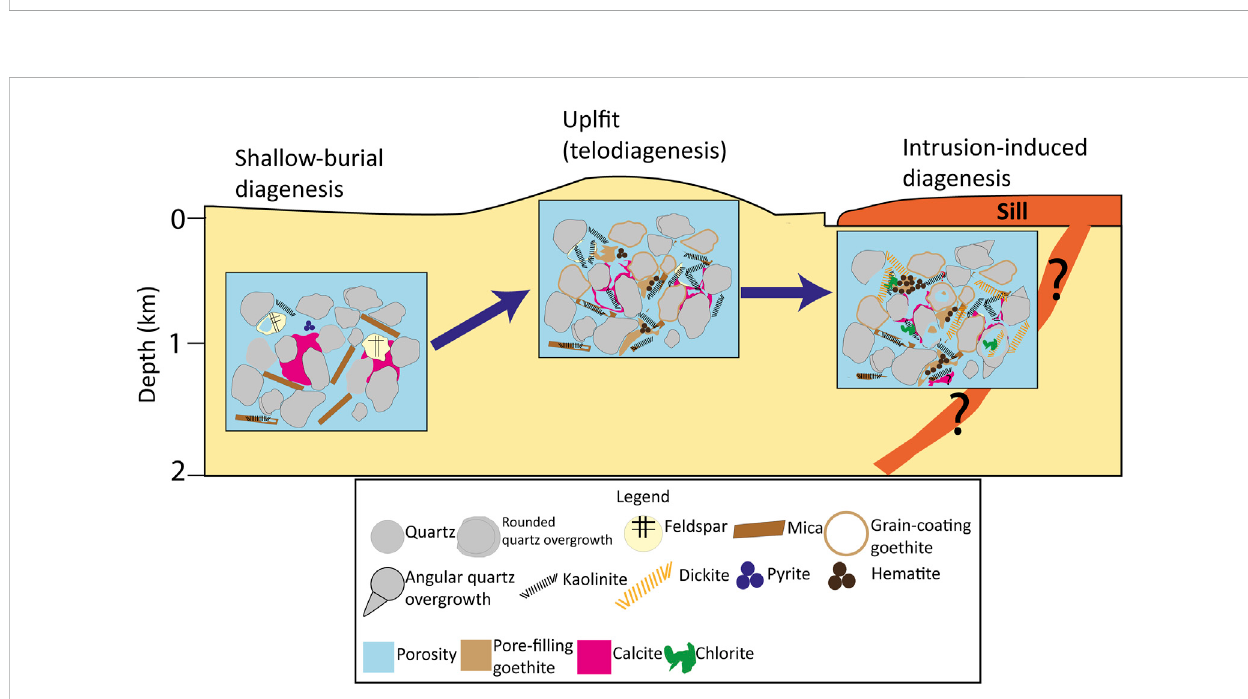
FIGURE 17 Conceptual model for the diagenetic processes in the studied Qasim